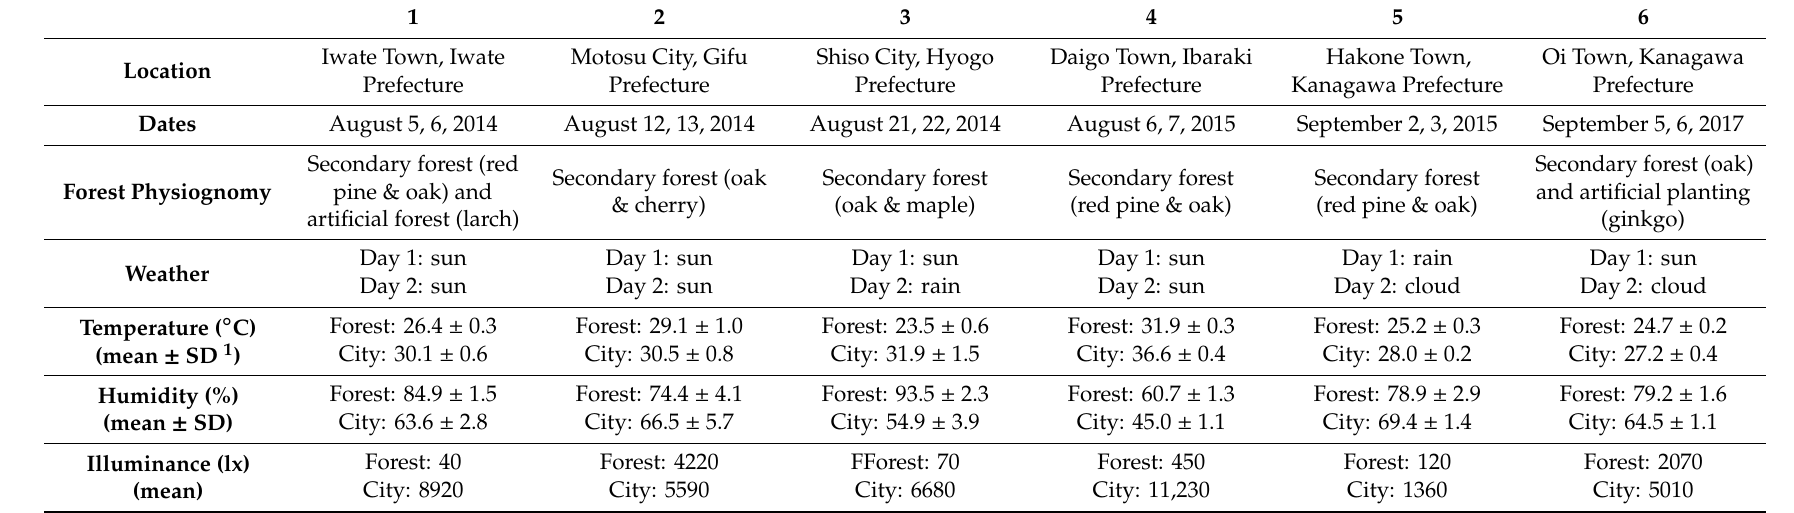
Table 2. Details of the experiment